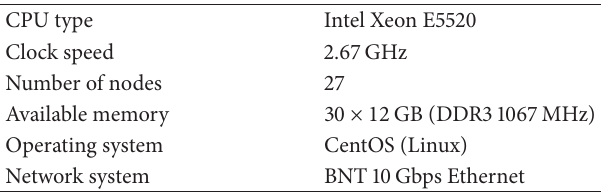
Table 4: Tissue parameters for HUGO